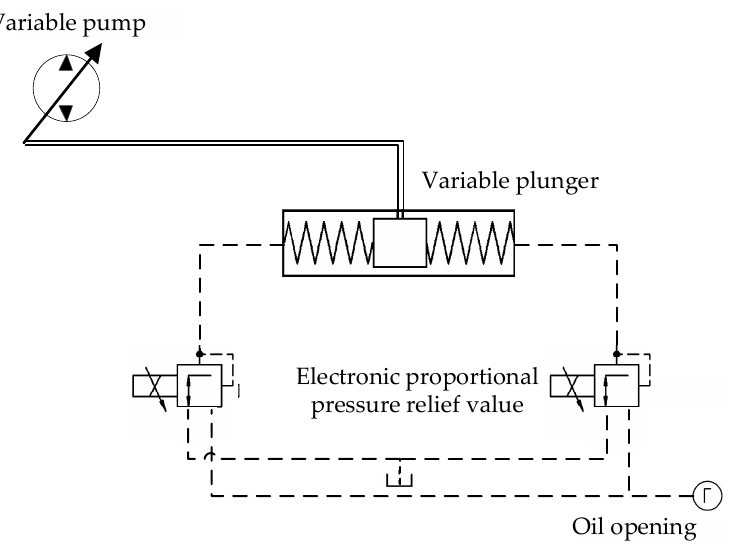
Figure 2. A simplified diagram of the control work principle of the variable pump. The system uses the PWM (Pulse Width Modulation) to control the electronic propor- tional pressure relief valve and then affect the oil pressure in the left and right oil chambers of variable plunger. Meanwhile, the variable plunger may spontaneously move to the